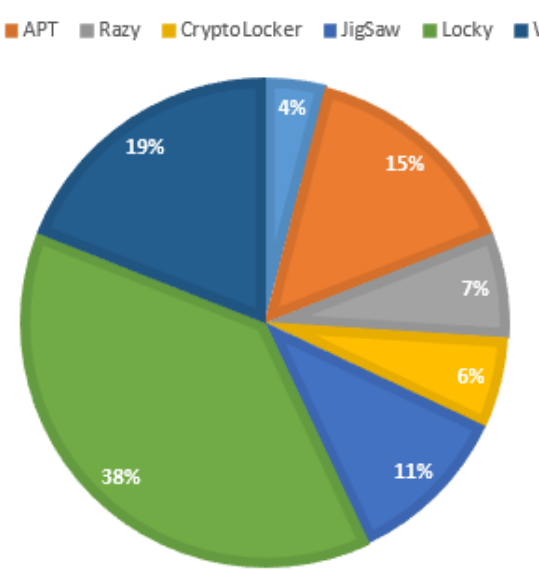
Figure 6. The financial damages caused by